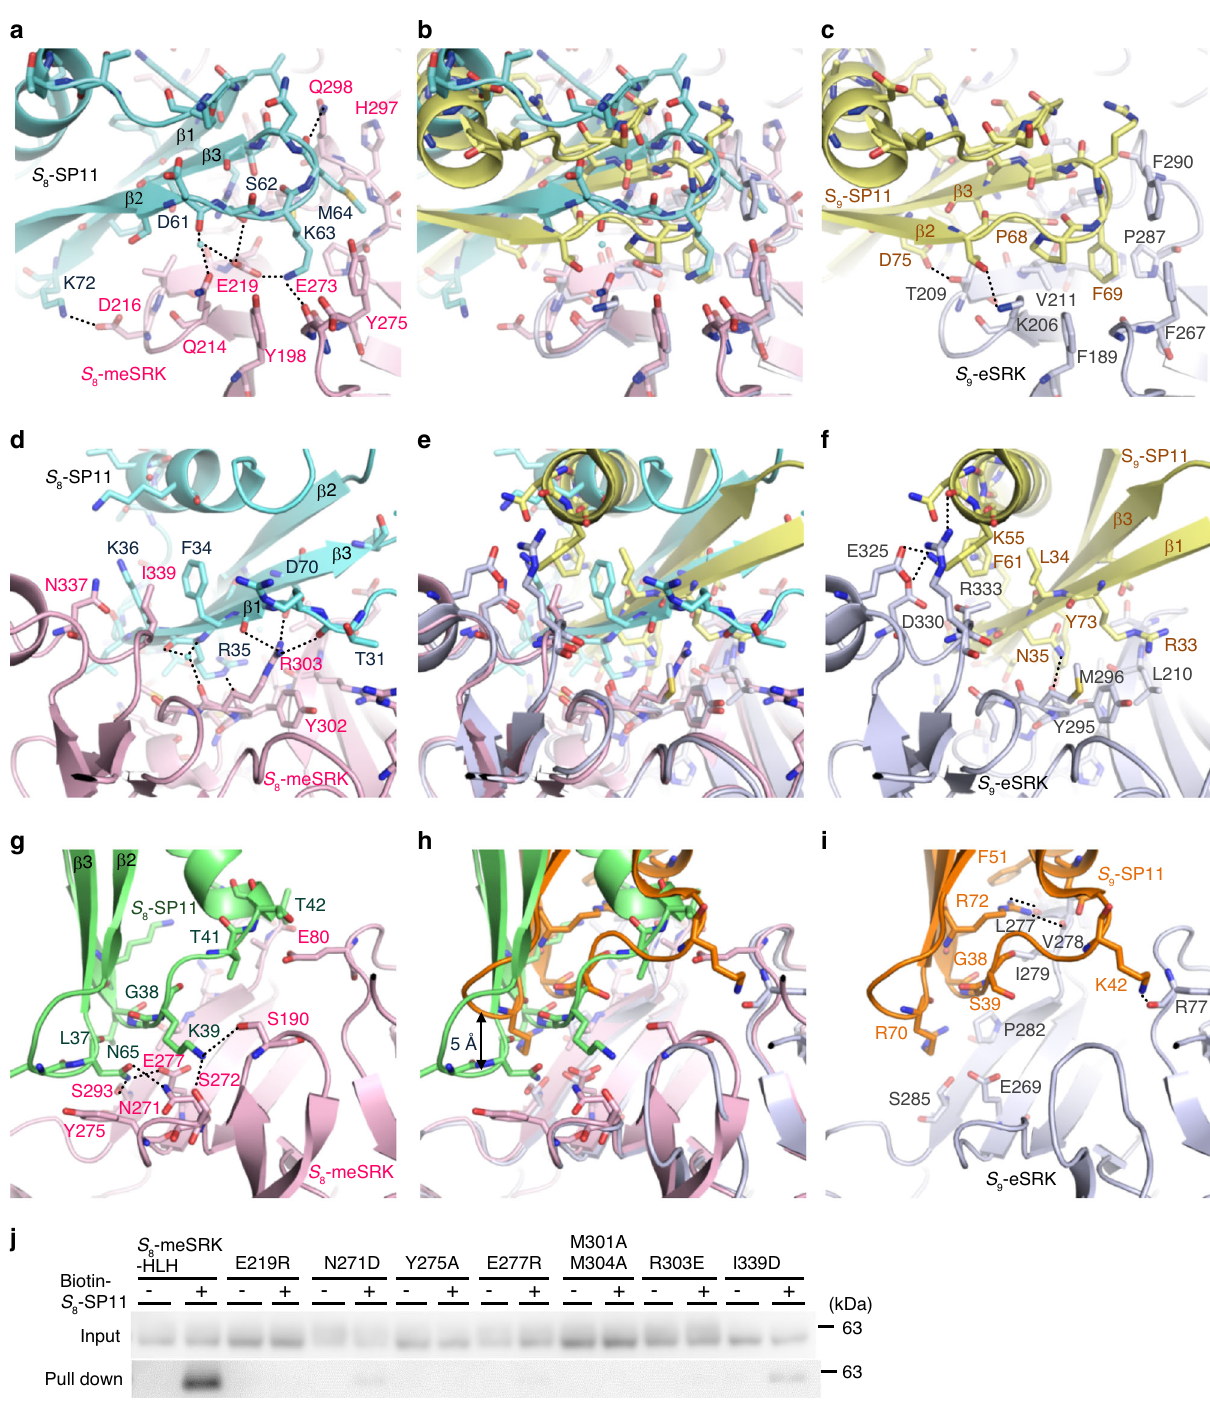
Fig. 2 Interface between S 8 -meSRK and S 8 -SP11. a , d Close-up views of SP11-binding site 1 on S 8 -meSRK (pink) with S 8 -SP11 (cyan). g Close-up view of SP11-binding site 2 on S 8 -meSRK with another molecule of S 8 -SP11 (green). b , e , h Comparison of SP11-binding sites of eSRK between the S 8 -meSRK – S 8 - SP11 and S 9 -eSRK – S 9 -SP11 complexes. The eSRK molecules were superimposed using C α atoms and show the same views as in a, d, and g, respectively. S 9 - eSRK is shown in silver, and S 9 -SP11 in yellow (interacting with SP11-binding site 1) and orange (site 2). c , f , i Close-up views of S 9 -eSRK – S 9 -SP11 complex in the same orientation as in ( b ), ( e ), and ( h ). a – i , Dotted lines represent hydrogen bonds. Water molecules are shown as small cyan spheres. j Pull-down of S S 8 -meSRK-HLH mutants with biotin- 8 -SP11 as in Fig.